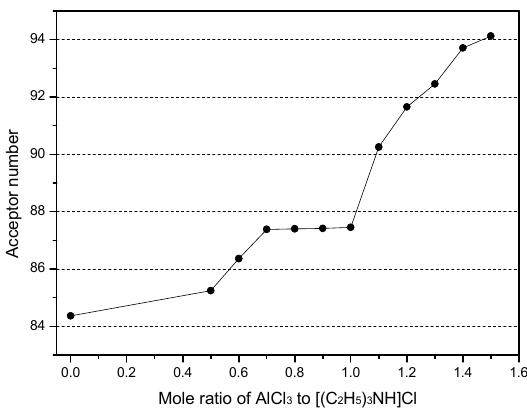
Figure 4. Effects of AlCl 3 on the AN value of [(C 2 H 5 ) 3 NH]Cl − CuCl.